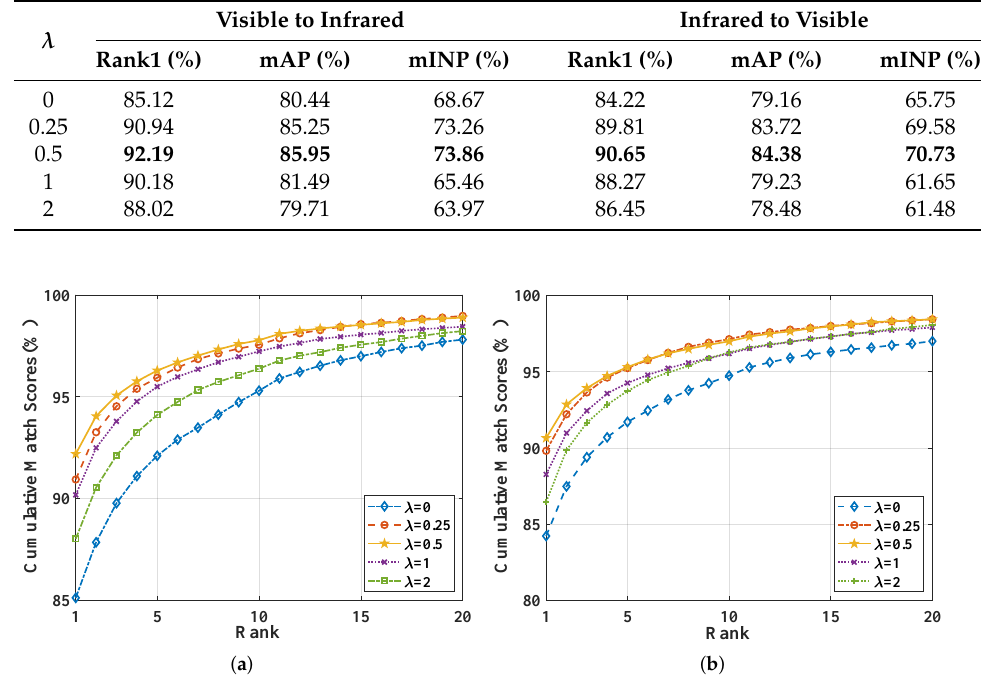
Figure 4. The CMC curves in different MMFSD’s weights (i.e., λ in Equation (9)) on RegDB dataset of ( a ) visible-to-infrared retrieval and ( b ) infrared-to-visible